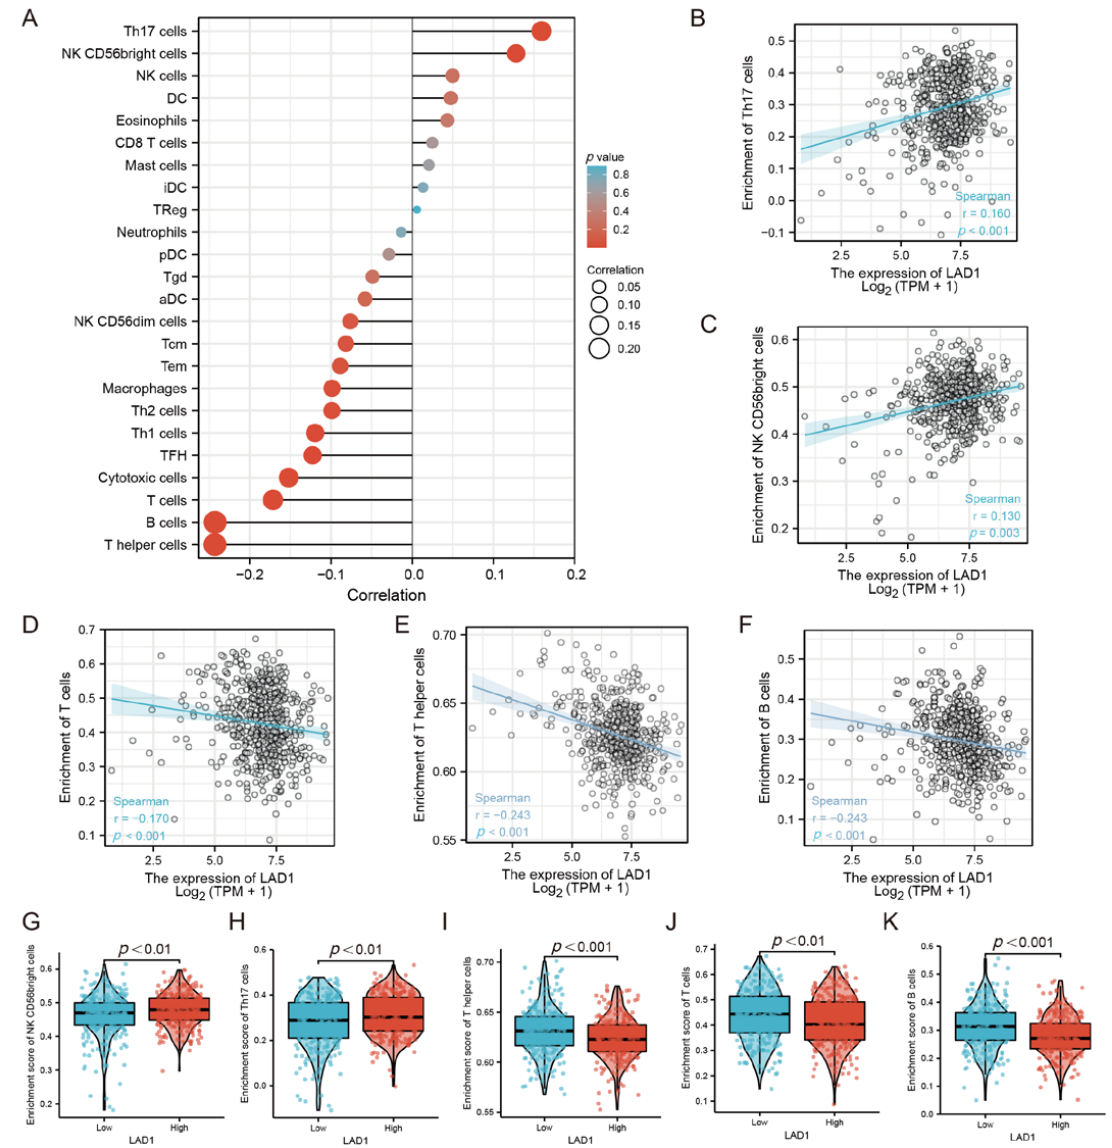
Figure 4. The relationship between LAD1 expression and immune infiltration. ( A ) The correlation between the relative abundance of 24 immune cells and LAD1 expression. The dot sizes represent the absolute Spearman’s correlation coefficient values. LAD1 expression was positively correlated with the abundance of innate immune cells, such as Th17 cells ( B ) and NK CD56 bright cells ( C ), and negatively correlated with acquired immune cells, such as T cells ( D ), T helper cells ( E ), and B cells ( F ). NK CD56 bright cells and Th17 cells were enriched in the LAD1 high-expression group ( G , H ); T helper cells, T cells, and B cells were enriched in the LAD1 low-expression group ( I – K ). 2.5. GSVA Identified LAD1 Overexpression Relates with “K-Ras Addiction”